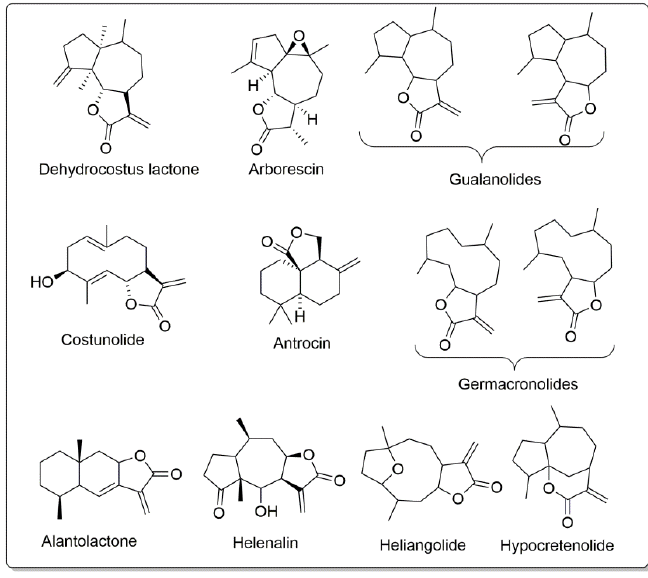
Figure 1. Basic skeleton of sesquiterpene lactones.